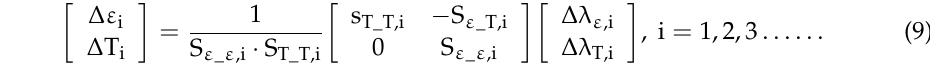
Figure 5. Temperature sensitivity of different sensing units.